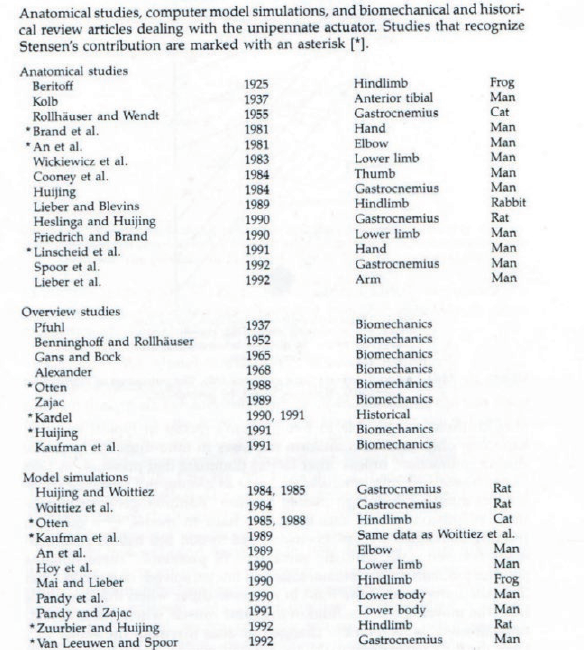
Figure 4. Anatomical studies, computer model simulations and biomechanical and historical review articles dealing with the uni- pennate actuator. Studies that recognise Stensen’s contribution are marked with an asterisk ([*]: [17], p. 49 and